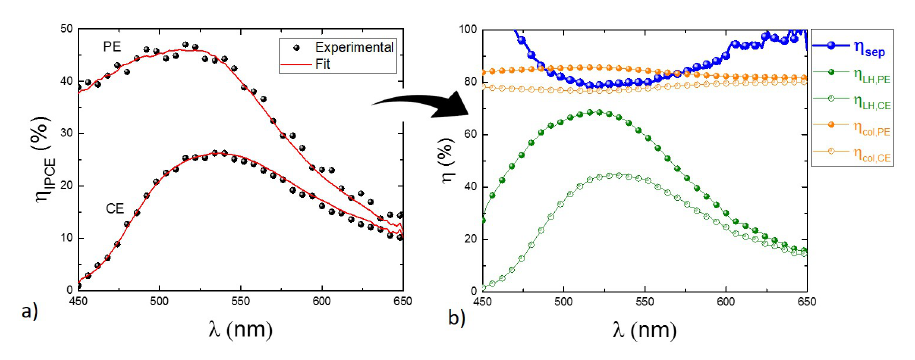
and η IPCE by varying the η sep spectrum for Point “H” of Figure 6d. PE CE